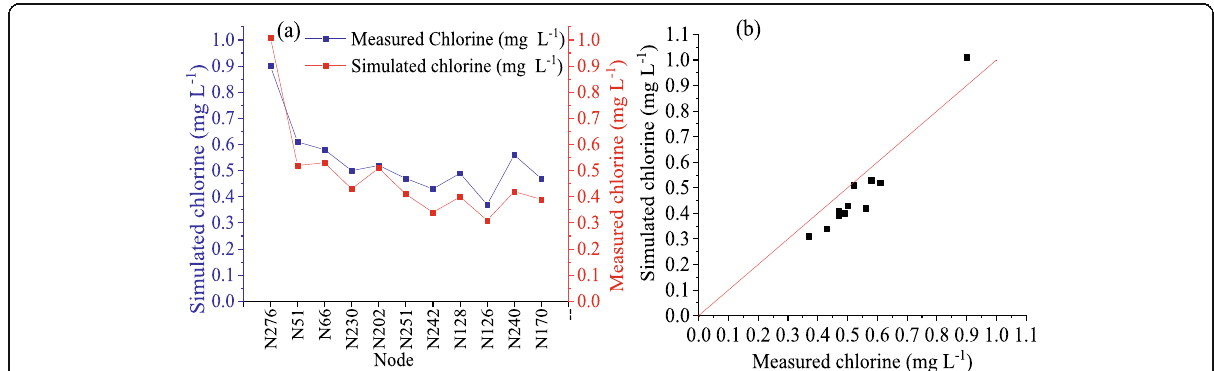
Fig. 6 a Comparison of computed and measured chlorine concentration during the validation b Pearson correlation results between computed and measured chlorine concentration during the